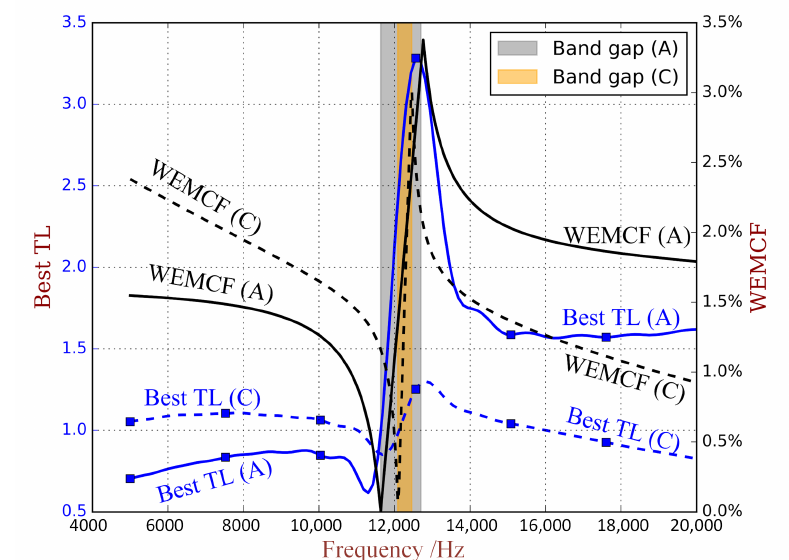
Figure 16. The best TL and WEMCF with respect to the frequency for PZT waveguide with unit cell A and unit cell